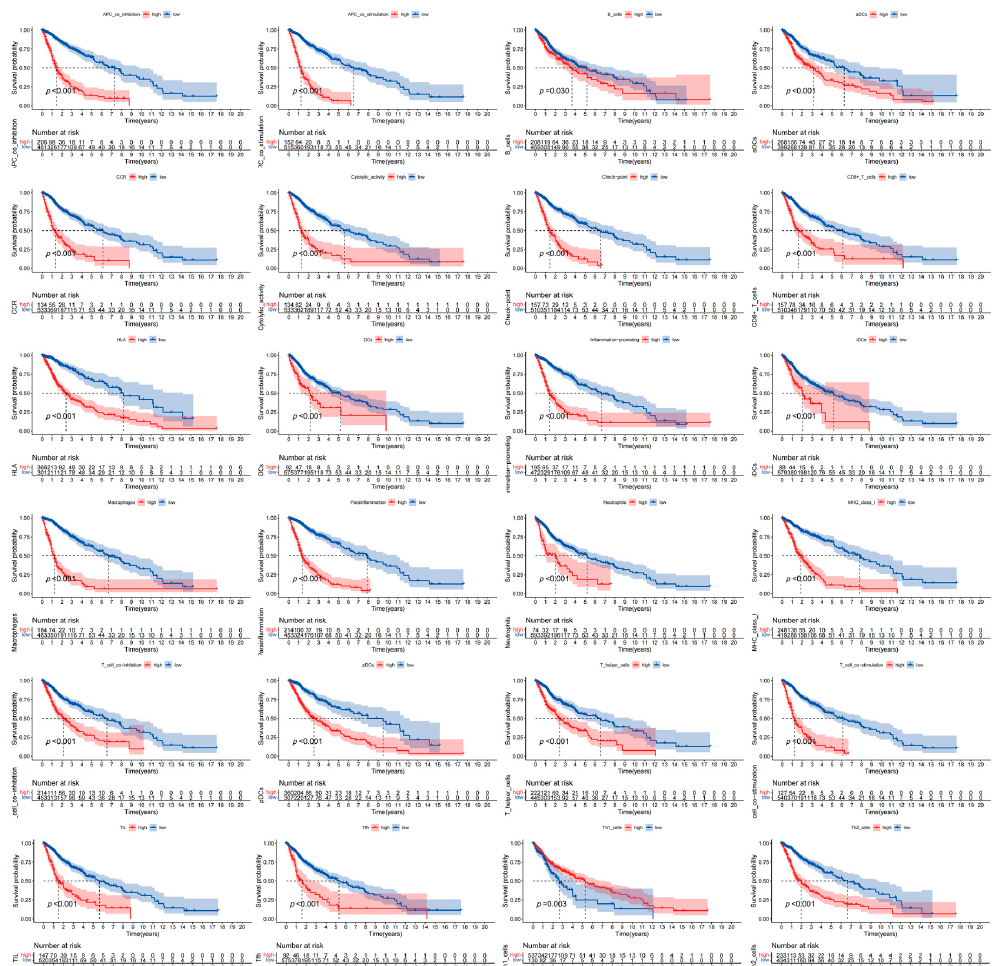
Figure A6. Kaplan–Meier curves of immune function features correlated with the prognosis of glioma.